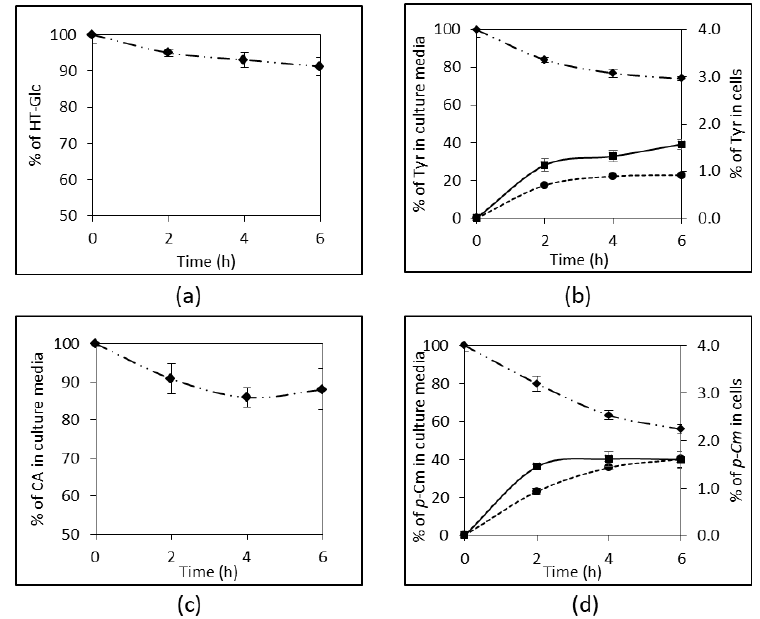
Figure 3. Recovery of the phenolic compounds in both the apical and basolateral chambers, and in Caco-2 cell compartment. ( a ) HT-Glc; ( b ) Tyr; ( c ) CA; and, ( d ) p -Cm. All results are expressed as percentage of the initial amount at the apical side. Values are expressed as mean ± SD ( n = 4). ◆ : apical side; ●: basolateral side; ■ : Caco-2 cells.